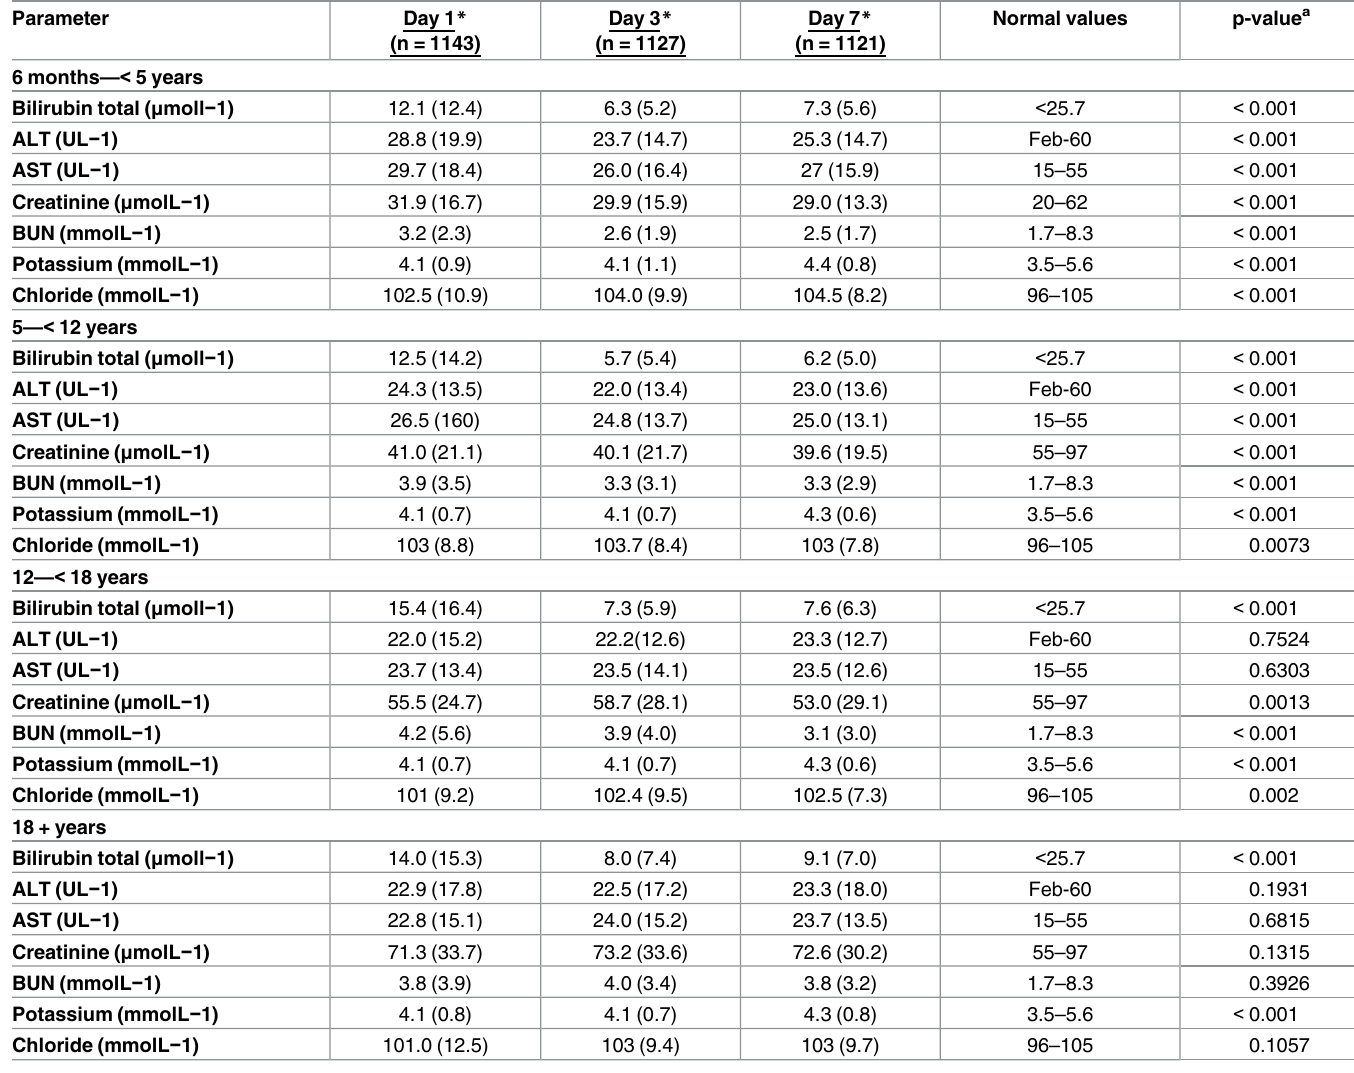
Table 3. Background and laboratory